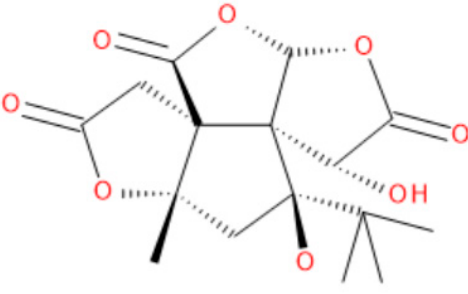
Figure 7. Chemical structure of Bilobalide.